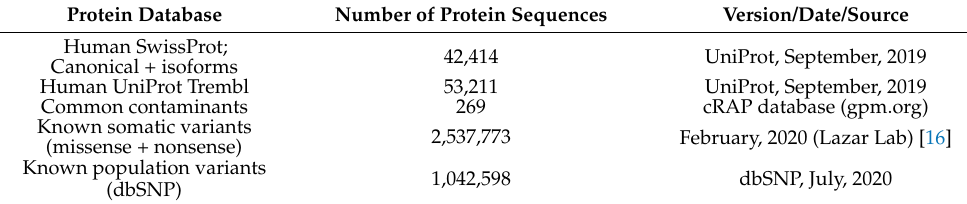
Table 1. A summary of the protein sequences utilized in this study. Protein Database Number of Protein